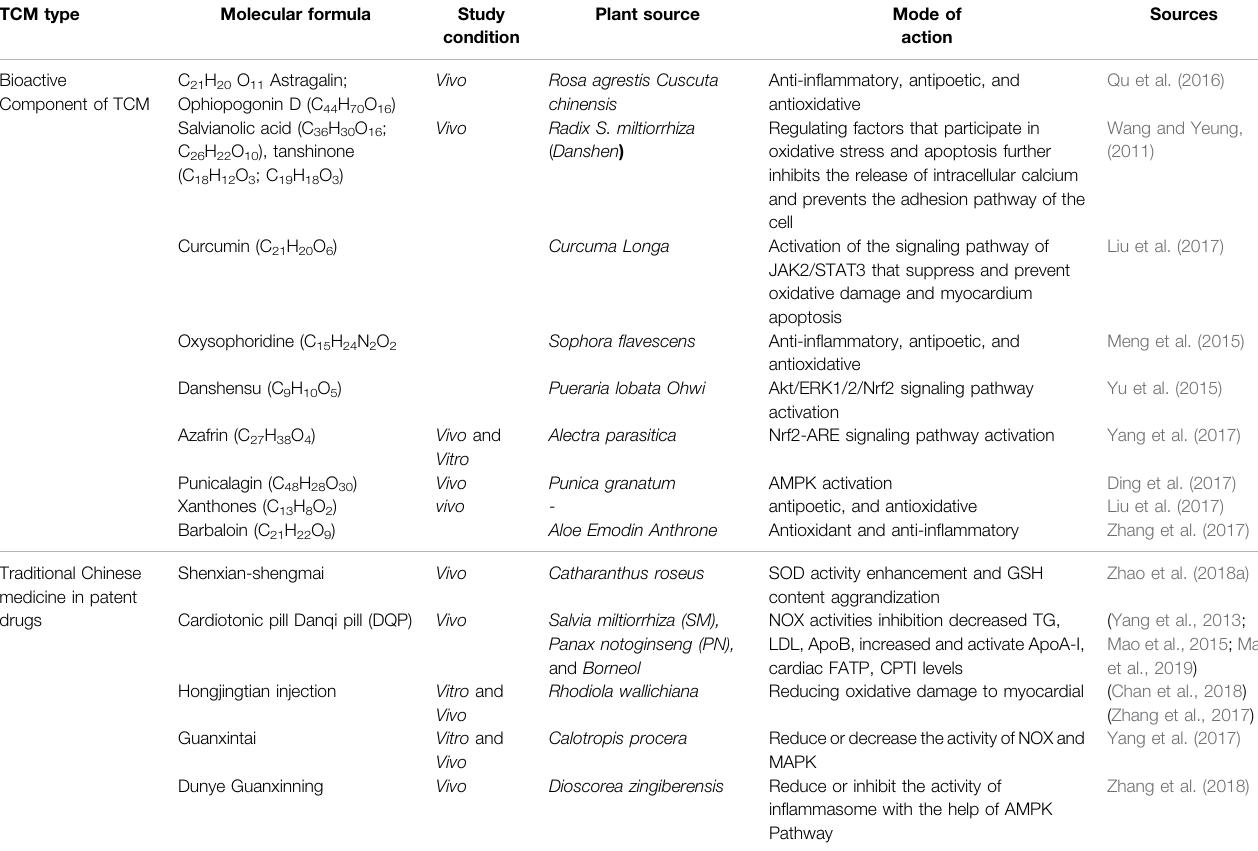
TABLE 2 | Reducing ROS in myocardial infraction by